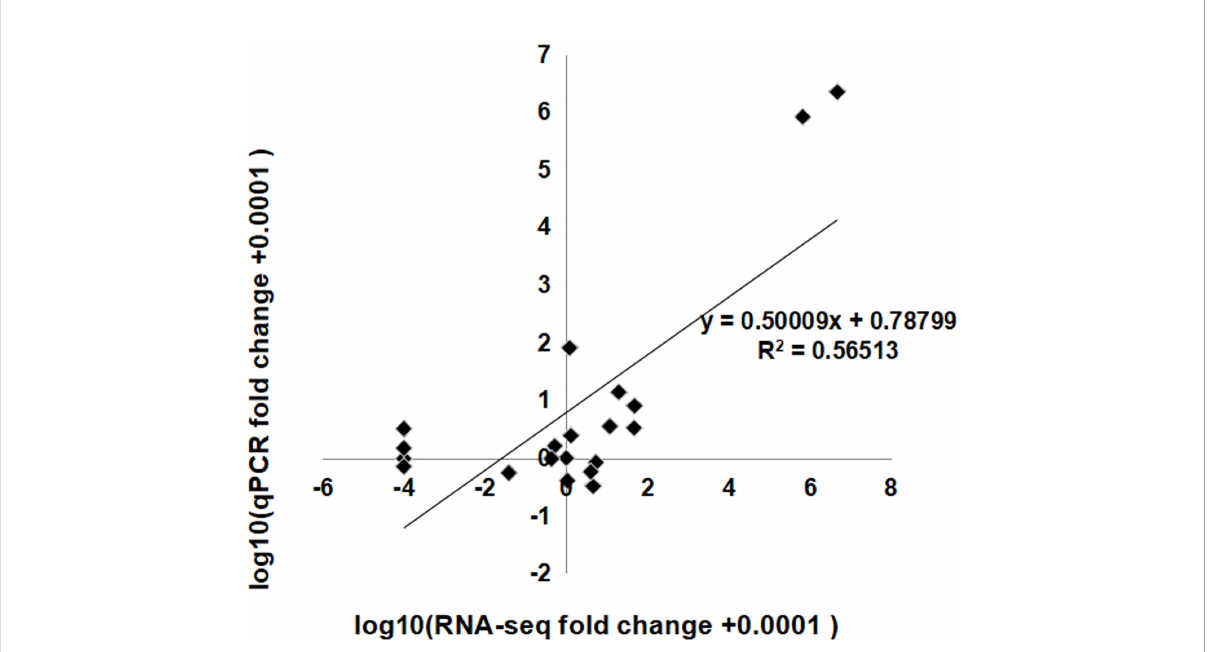
FIGURE 7 Coef fi cient analysis between lncRNA expression ratios obtained by RNA-seq and qRT-PCR data. RNA-Seq fold change refers to the ratios of RPKM values of SF, LF to EF for selected transcripts, while qRT-PCR fold change is the relative quantity of SF, LF normalized to the expression level of EF. EF, early- fl owering stage; SF, semi- fl owering stage; LF, late- fl owering